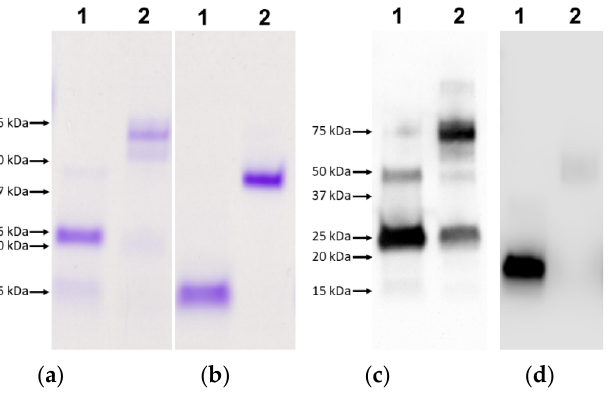
Figure 2. Characterisation of LTB oligomerisation. Both proteins rLTB ‐ FhTSP2 ( a , c ) and rLTB ( b , d ) were loaded at 6 μ g and subject to boiling at 95 C for 10 min. Boiled (lane 1) and non ‐ boiled (lane 2) proteins were analysied by SDS ‐ PAGE and visualized by Coomassie staining ( a , b ) and Western blotting ( c , d ) using anti ‐ His tag antibodies.